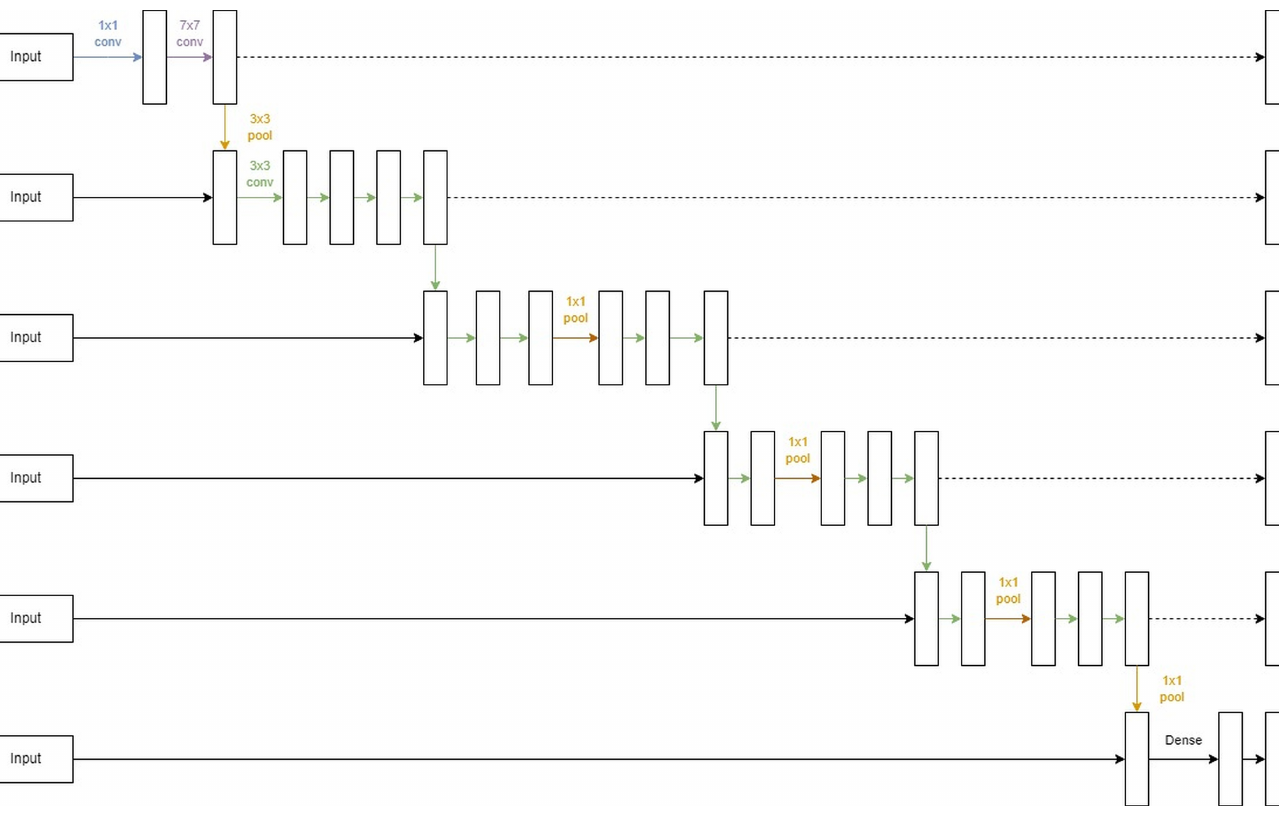
Figure 3. Architecture of the U-lossian network classifier. Table 1. Hyper-parameters of the U-lossian